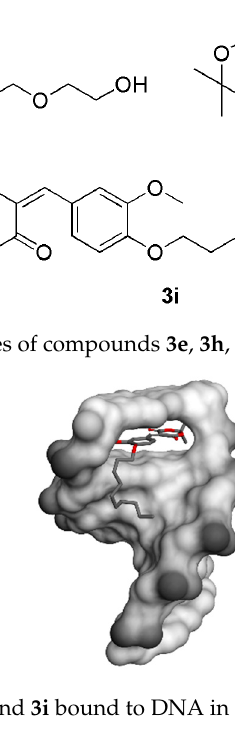
Figure 1. Structures of c ompounds 3e , 3h , and 3i .